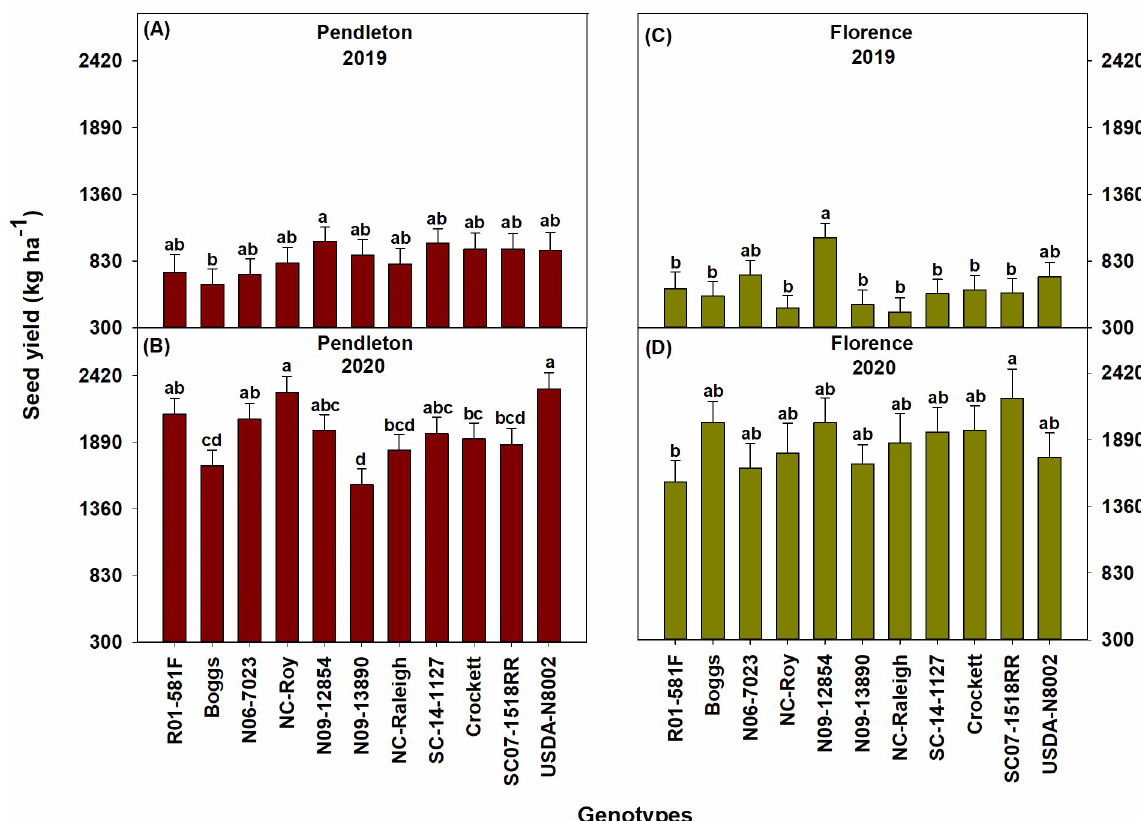
Fig 4. The seed yield of the soybean genotypes at Pendleton and Florence in 2019 and 2020. Seeds were harvested at full maturity [growth stage, R8; [71]] at 146 and 169 days after planting at Pendleton in 2019 and 2020, respectively, and 156 and 158 days after planting at Florence in 2019 and 2020, respectively. Bars represent least squares means and error bars represent standard errors. Least squares means with different letters are significantly different according to the Fisher’s least significant difference (LSD) test at α < 0.05.